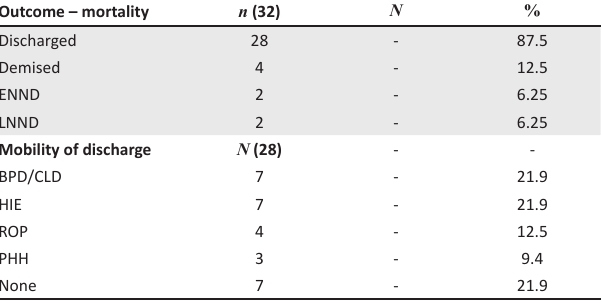
TABLE 3: Outcome of Carbapenem-resistant Enterobacteriaceae -infected neonates. Outcome –